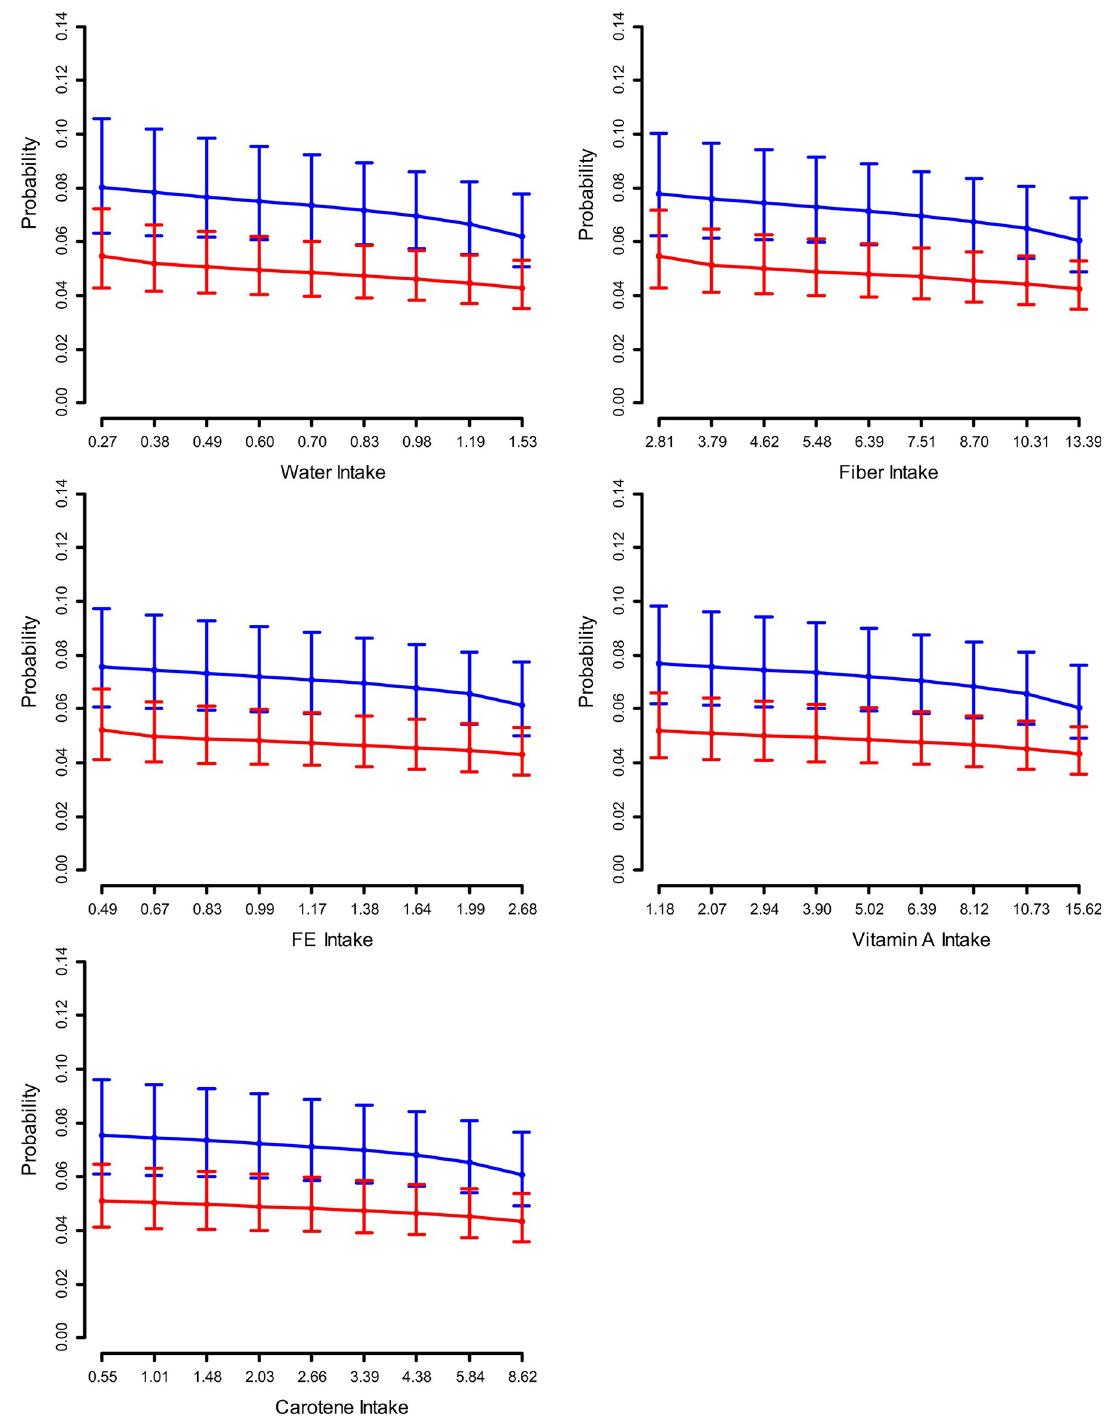
Fig 1. The incidence of ILD according to intake of water and some nutrients by participants. Participants were divided into 10 groups according to their dietary intake. The probability of having ILD decreased when intake of dietary factors (water, fiber, iron, vitamin A, and carotene) is increased. Two horizontal bars represent the 95% confidence interval.